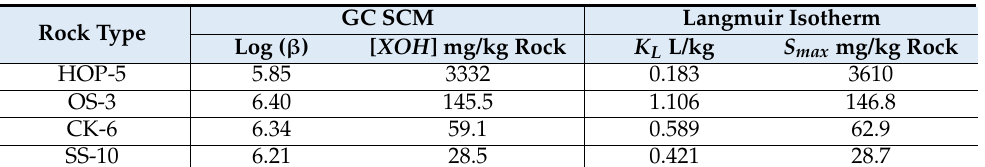
Table 4. GC SCM and Langmuir isotherm parameters associated with the best fits to the data sets for each rock type (model curves shown in Figures